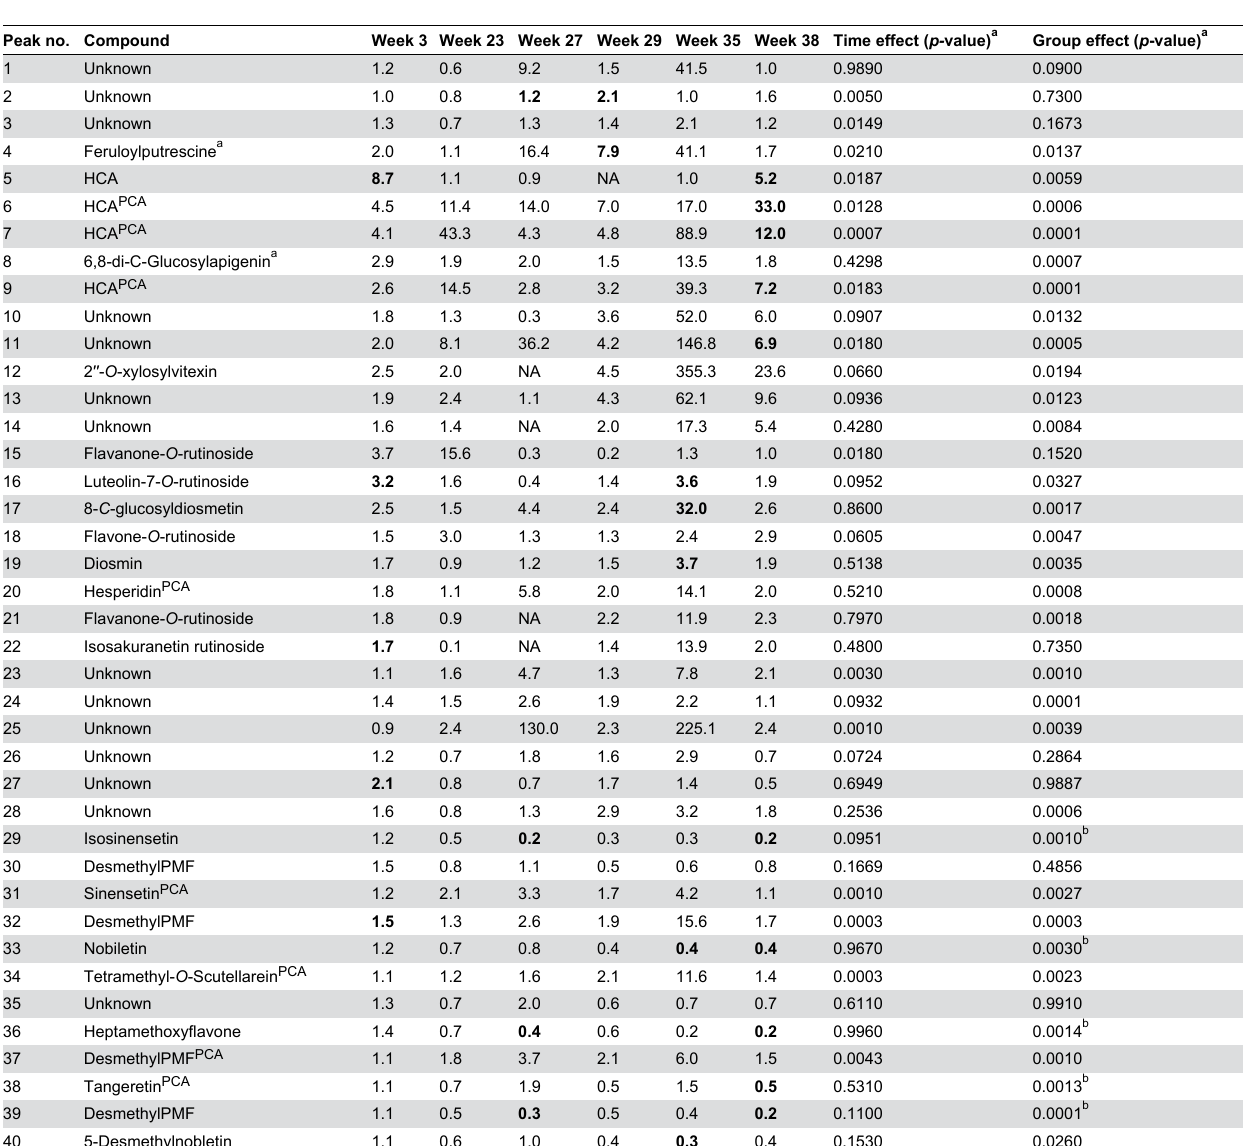
Table 6. The relative amounts of metabolites from C Las-inoculated ‘Hamlin’ trees with respect to control ‘Hamlin’ trees.